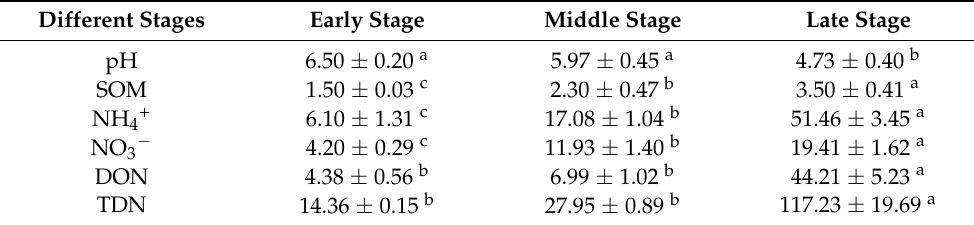
Table 1. Values of soil pH, contents of SOM (g · kg − 1 ), NH 4+ , NO 3 − , DON, TDN (mg · kg − 1 ) of at different successional